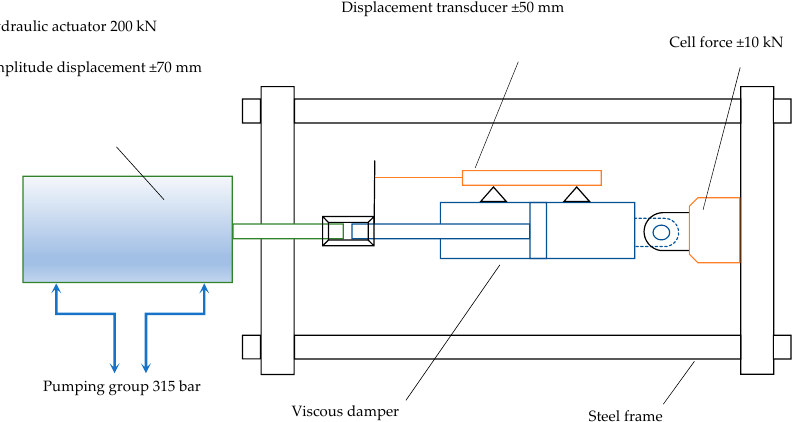
Figure 2. Experimental setup.